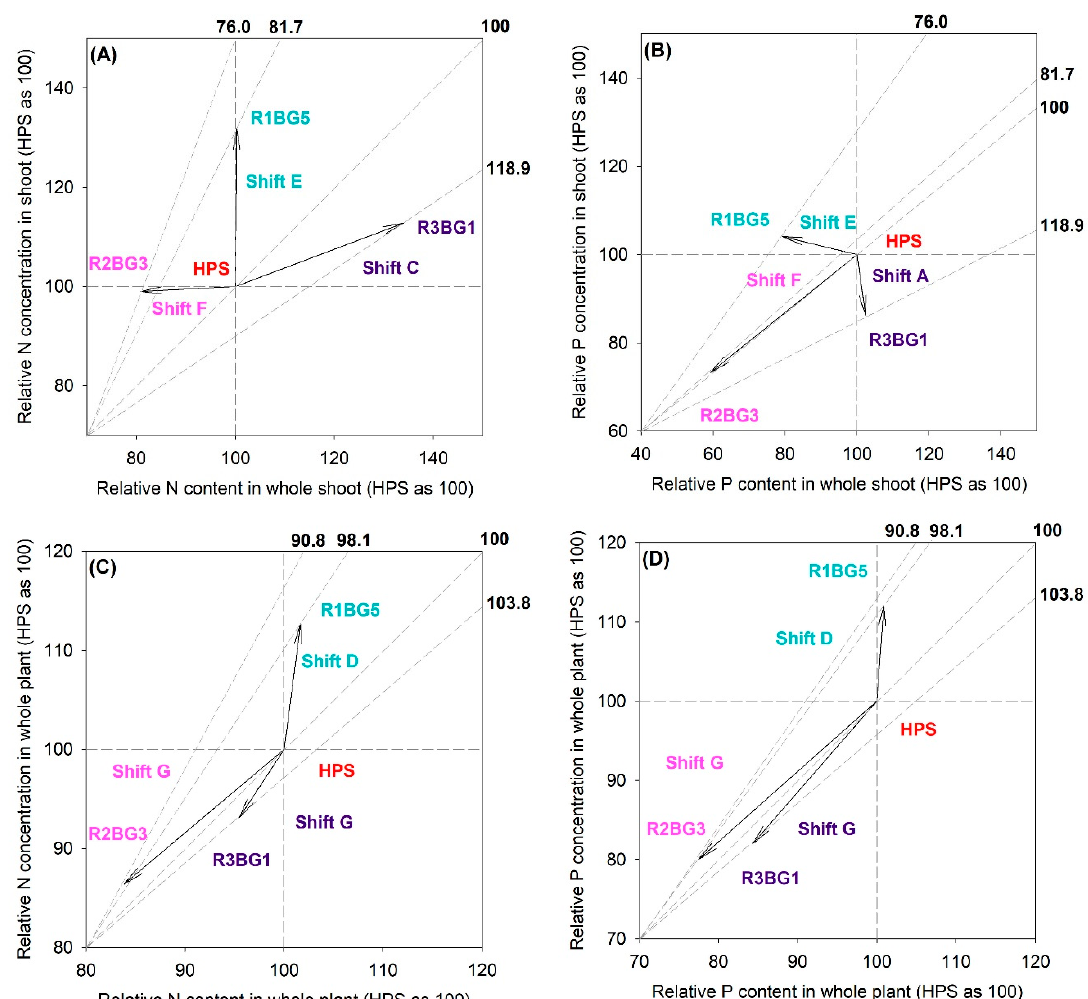
Figure 7. Vector analysis on N (left) and P (right) statuses in shoots (top) and whole plants (bottom) of Korean pine ( Pinus koraiensis ) seedlings under three LED-spectra treatments (R1BG5, R2BG3, and R3BG1) with the HPS spectrum as the reference. Shift A—nutrient dilution, Shift C—nutrient deficiency, Shift D—steady-state accumulation, Shift E—toxic excess, Shift F—antagonistic excess, Shift G—nutrient depletion. Interpretations were adapted from Salifu and Timmer [25]. Subfigures A and B present vector analysis on N and P statuses in shoot, respectively. Subfigures C and D present vector analysis on N and P statuses in whole-plant, respectively.